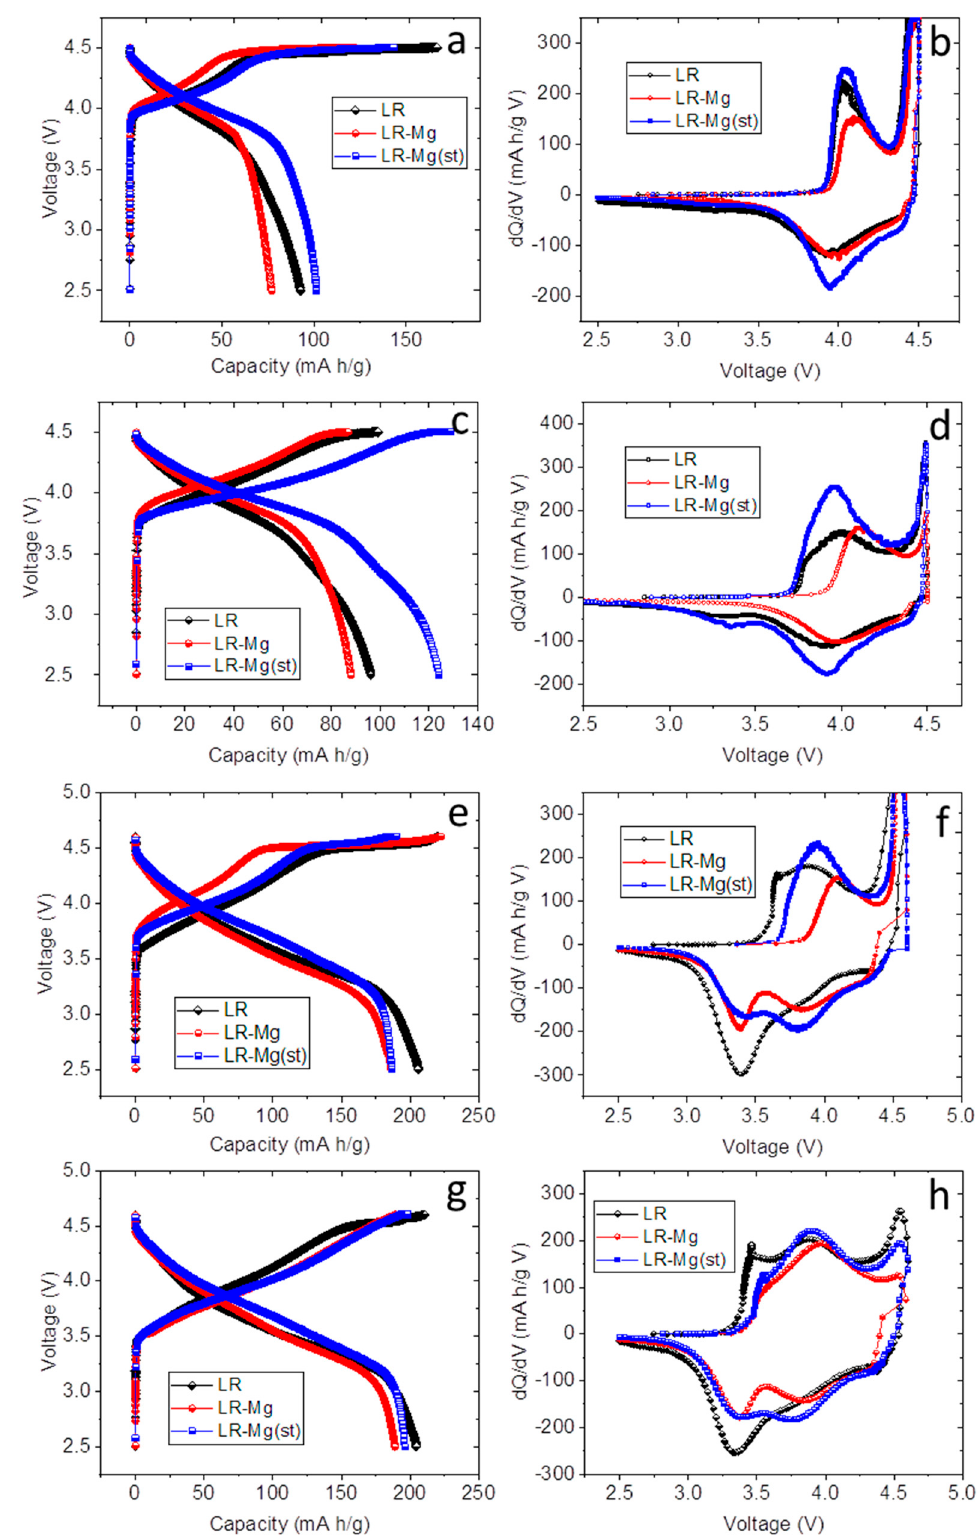
Figure 5. ( a , c , e , g ) The charge ‐ discharge curves and ( b , d , f , h ) the corresponding differential capacity (dQ/dV) plots for the cycles in the potential ranges of ( a – d ) 2.5–4.5 V and ( e – h ) 2.5–4.6 V. The high peaks at 4.5 V ( b , f ) are not shown for clarity. Sample names are shown in the figures. With increases to upper charge voltage, the difference between the dQ/dV plots of the samples becomes more apparent. All the samples exhibited a new cathodic peak at